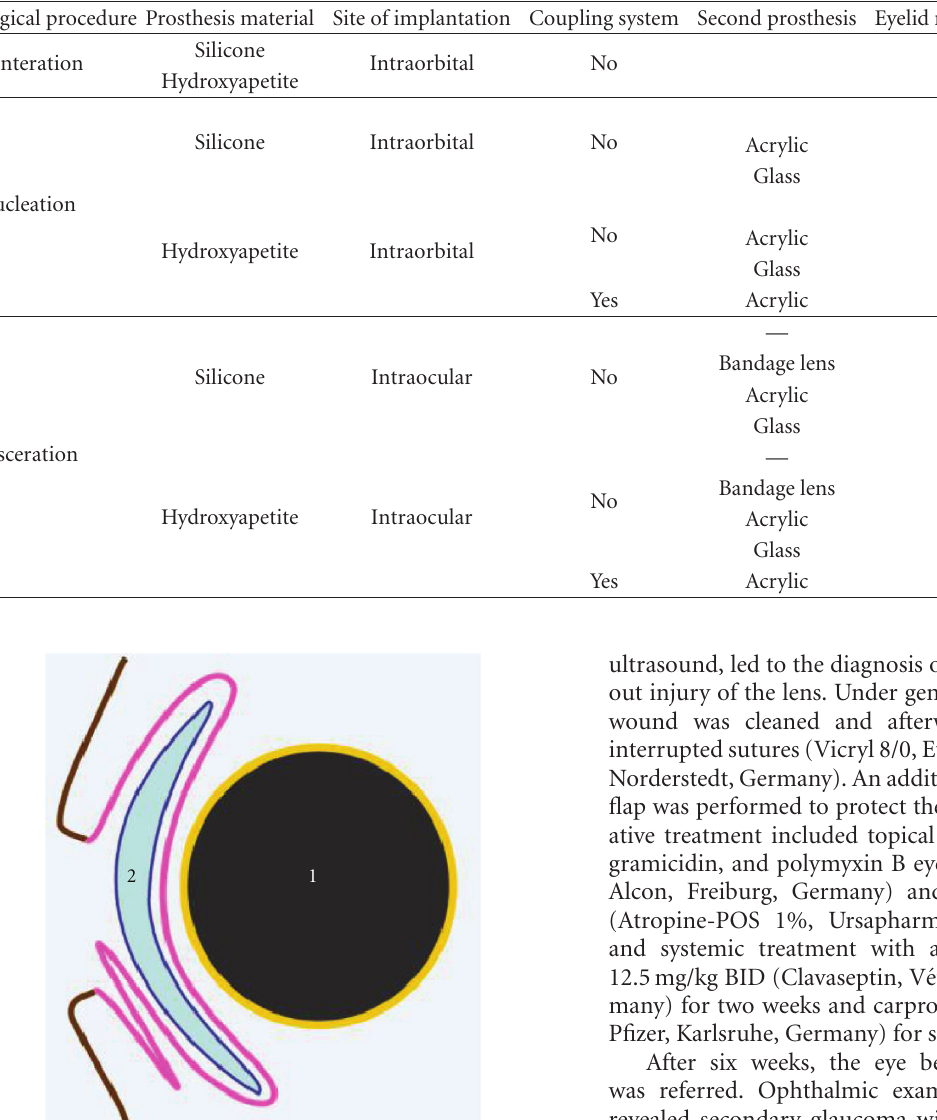
Table 1: Overview of selected options to restore anatomical structure after exenteration, enucleation, or evisceration [8, 10, 11]. Depending on the procedure and the selected prosthesis, a second prosthesis or an “artificial eye” can be placed between the first prosthesis and the eyelids. Porous implants like hydroxyapatite can be combined with a coupling or peg system, to give the second implant better motility [8, 10].